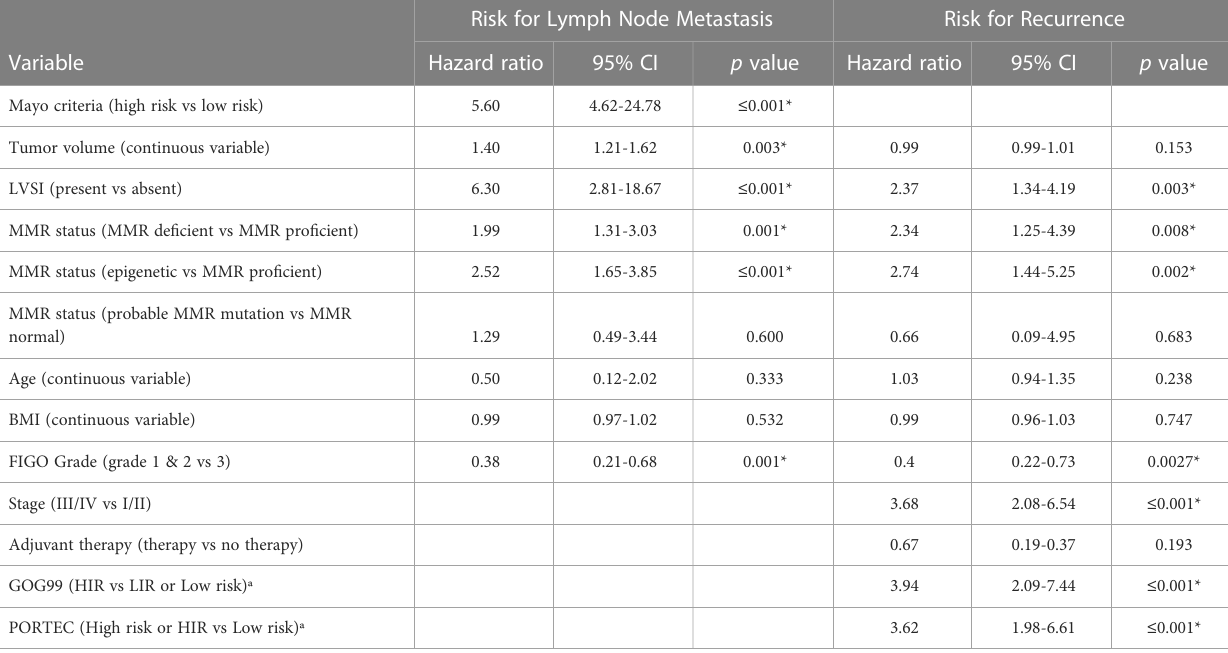
TABLE 2 Multivariate analysis risk for LN metastasis and risk for recurrence in endometrioid EC.